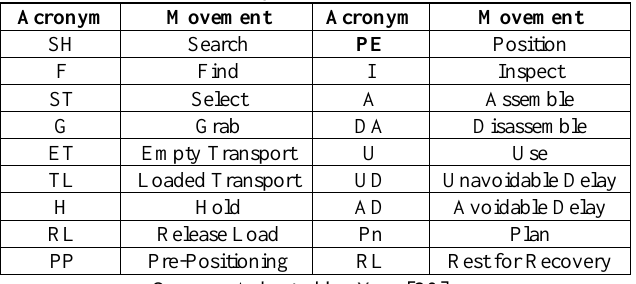
Table 1: Elementary movements of human